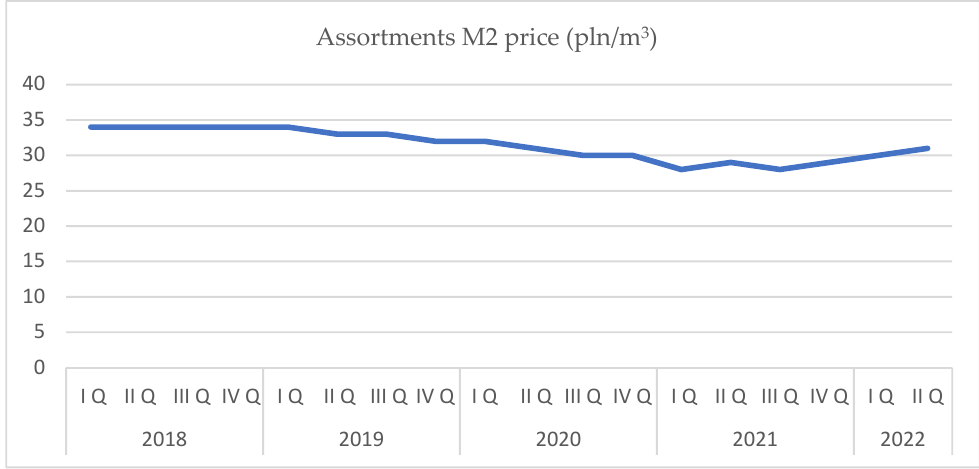
Figure 4. Prices for the M2 assortment at quarterly intervals in years 2018–2022. Source: Own elaboration based on data obtained from the State Forests IT System (SILP).